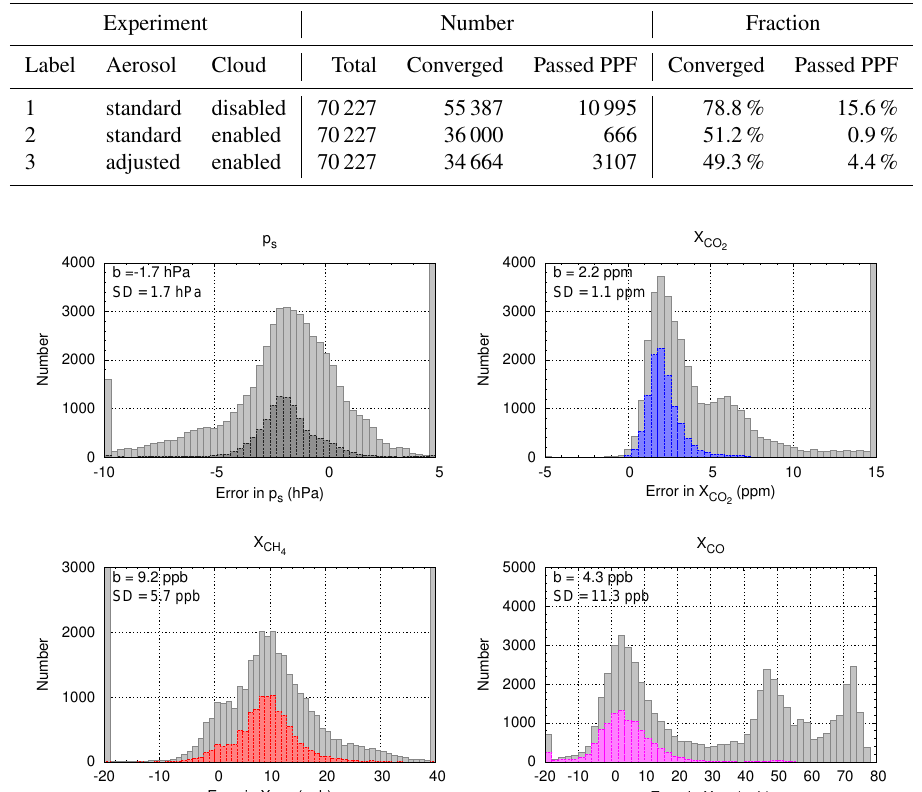
, X CH and X CO for experiment 1 with cloud-disabled and standard 2 4